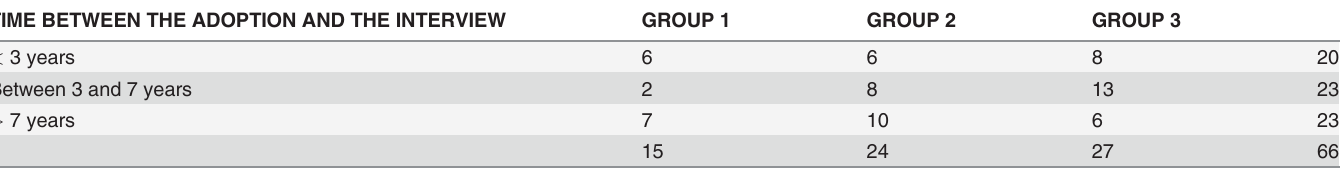
Table 4. Time between the adoption and the interview (according to group). TIME BETWEEN THE ADOPTION AND THE